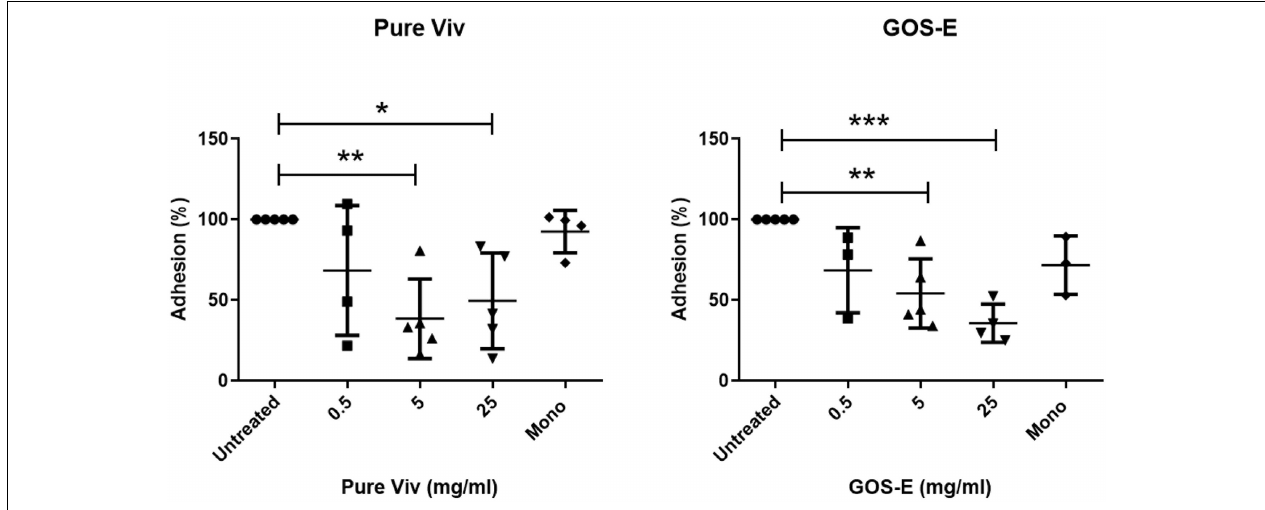
FIGURE 4 | Anti-adhesion experiments. Inhibition of E . coli HM605 adherence to C2BBe1 tissue culture cells by Pure Viv (left panel) or GOS-E (right panel) . The data were collected by counting the number of viable E. coli HM605 cells following C2BBe1 cell culture disruption. Significant differences were found for 5 and 25 mg/ml tests for both GOS substrates (see Table 9 ). Lines represent the standard deviations of the means; n = 5. The asterisks indicate statistically significant differences: * P ≤ 0.05; ** P ≤ 0.01; *** P ≤